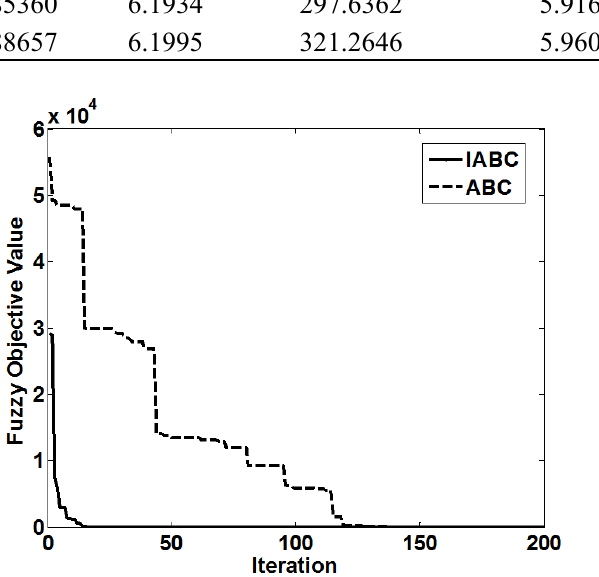
Figure 17. Convergence characteristics of the IABC and ABC algorithms for multi-objective OPF for the IEEE 300-bus